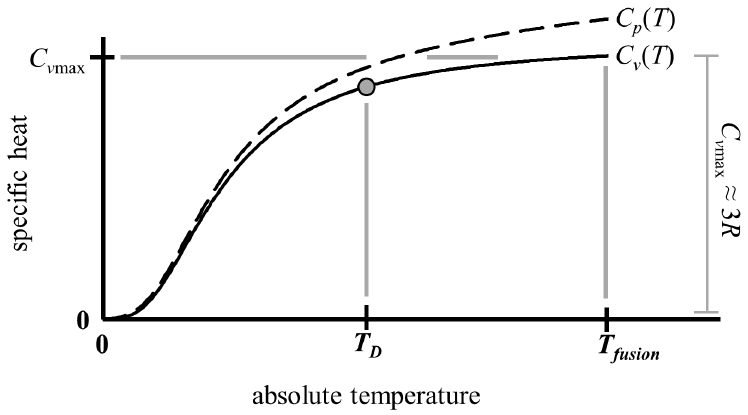
Figure 1. The general characteristics of temperature-dependent specific heat in solids. At absolute zero the constant-volume heat capacity curve, C v ( T ), originates and grows monotonically through the Debye Temperature ( T D ). A solid is often characterized by its Debye Temperature where its highest frequency vibrations are presumably excited [18]. The constant-volume heat capacity curve terminates when a solid melts at its temperature of fusion ( T fusion ). The solid’s maximal constant-volume specific heat is observed ( C v max ) at this location. Constant-pressure heat capacity, not constant-volume heat capacity, is usually engineering-relevant [20]. As shown, the constant-pressure curve C p ( T ) consistently exceeds the constant-volume curve C v ( T ).